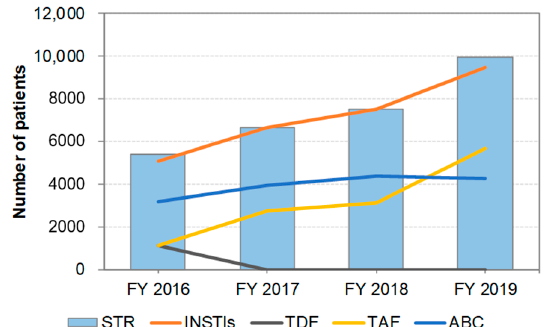
Figure 3. Change in the number of patients treated with STR from FY 2016 to FY 2019. The line graph indicates the number of patients treated with each ingredient of the STR (INSTIs, TDF, TAF, or ABC). The analysis was performed on drugs listed in Table 1. STR: single-tablet regimen, INSTI: integrase strand transfer inhibitor, TDF: tenofovir disoproxil fumarate, TAF: tenofovir alafenamide fumarate, ABC: abacavir .